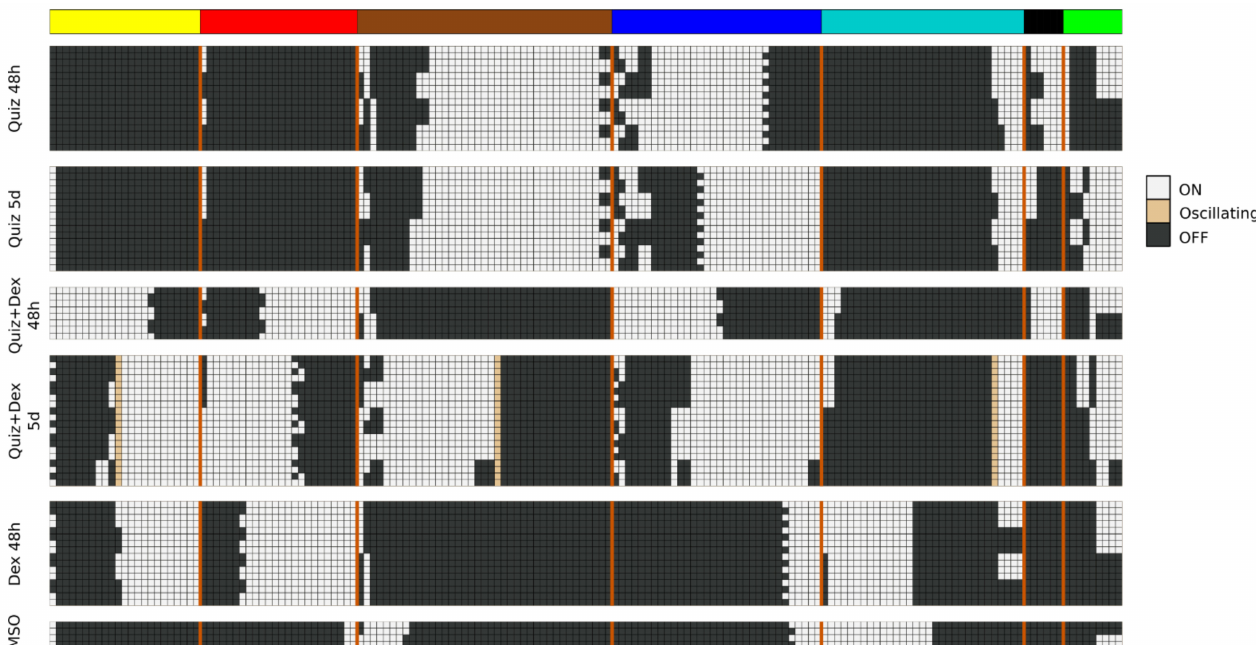
Figure 4. Pseudo-attractors corresponding to DMSO and drug-treated AML, which are also the attractors of the deterministic approximation of the BooleaBayes network. The values of the network’s 65 source nodes are fixed to match one of the six treatment conditions, including DMSO, and attractors of the reduced systems are shown above. Each row is one attractor, and columns are nodes of the network. Columns are grouped and colored based on the module the node belongs in. The vertical orange lines delimit the nodes of each